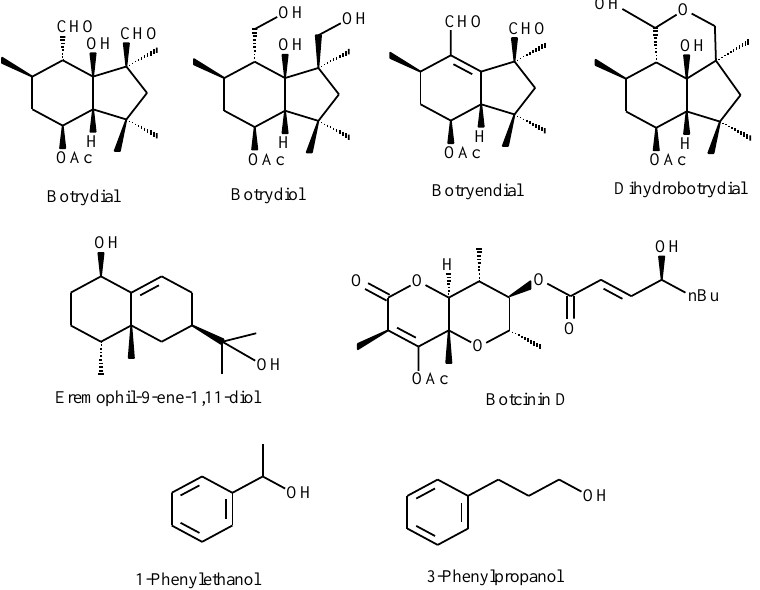
Figure 1. Compounds detected in B. cinerea extracts by high-performance liquid chromatography- tandem mass spectrometry (HPLC-MS/MS).